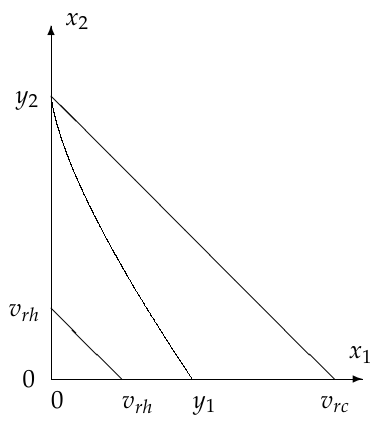
Figure 1. Corruption frontier for Theorem 2(iii).